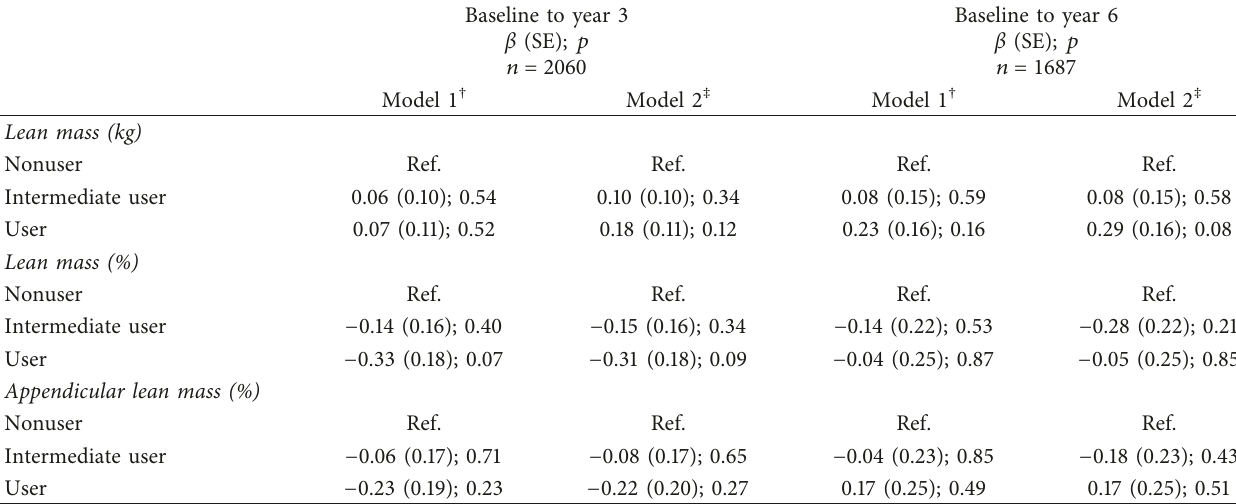
Table 3: Association between ACE-I/ARB use over time and change in lean mass in hypertensive women from the Women’s Health Initiative ∗ .